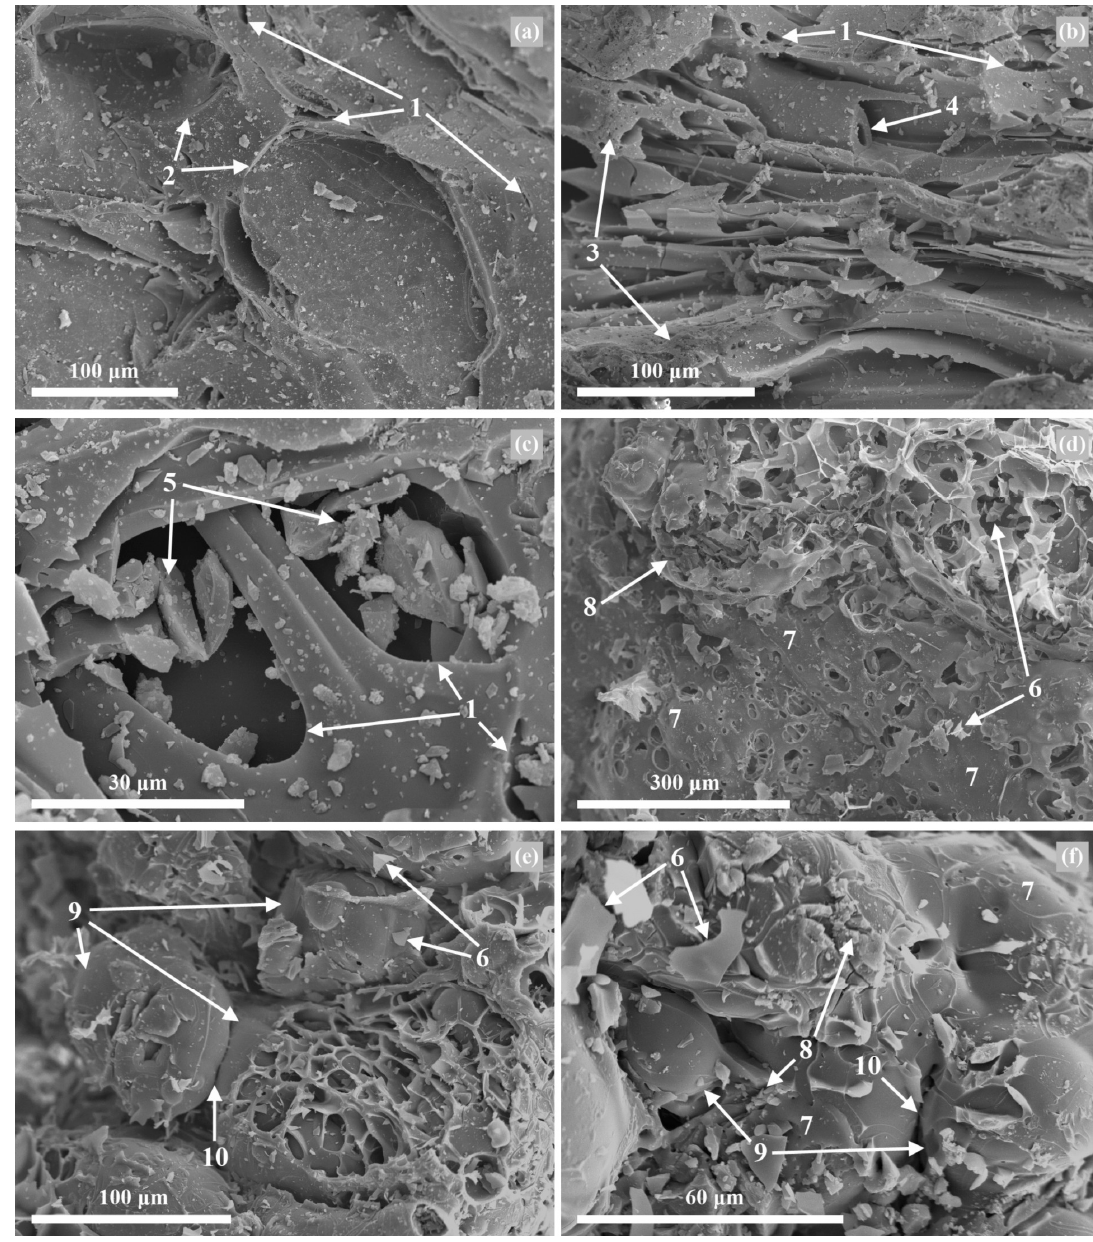
Figure 3. Secondary electron images of 1.18–2.5 mm industrial size fraction of Trachilas perlite